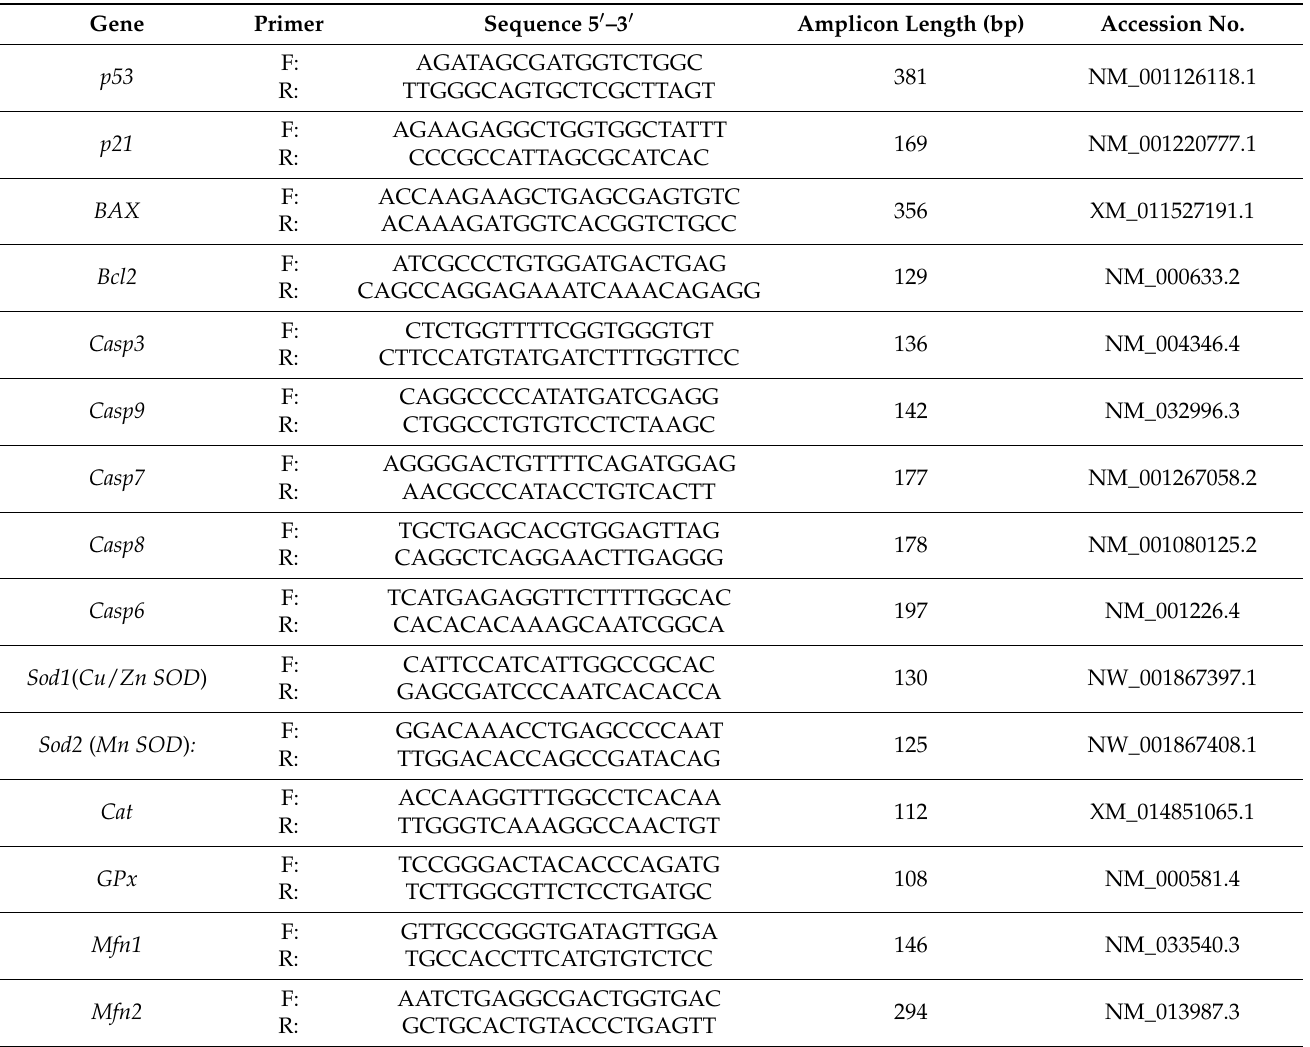
Table 1. Primers used for gene expression